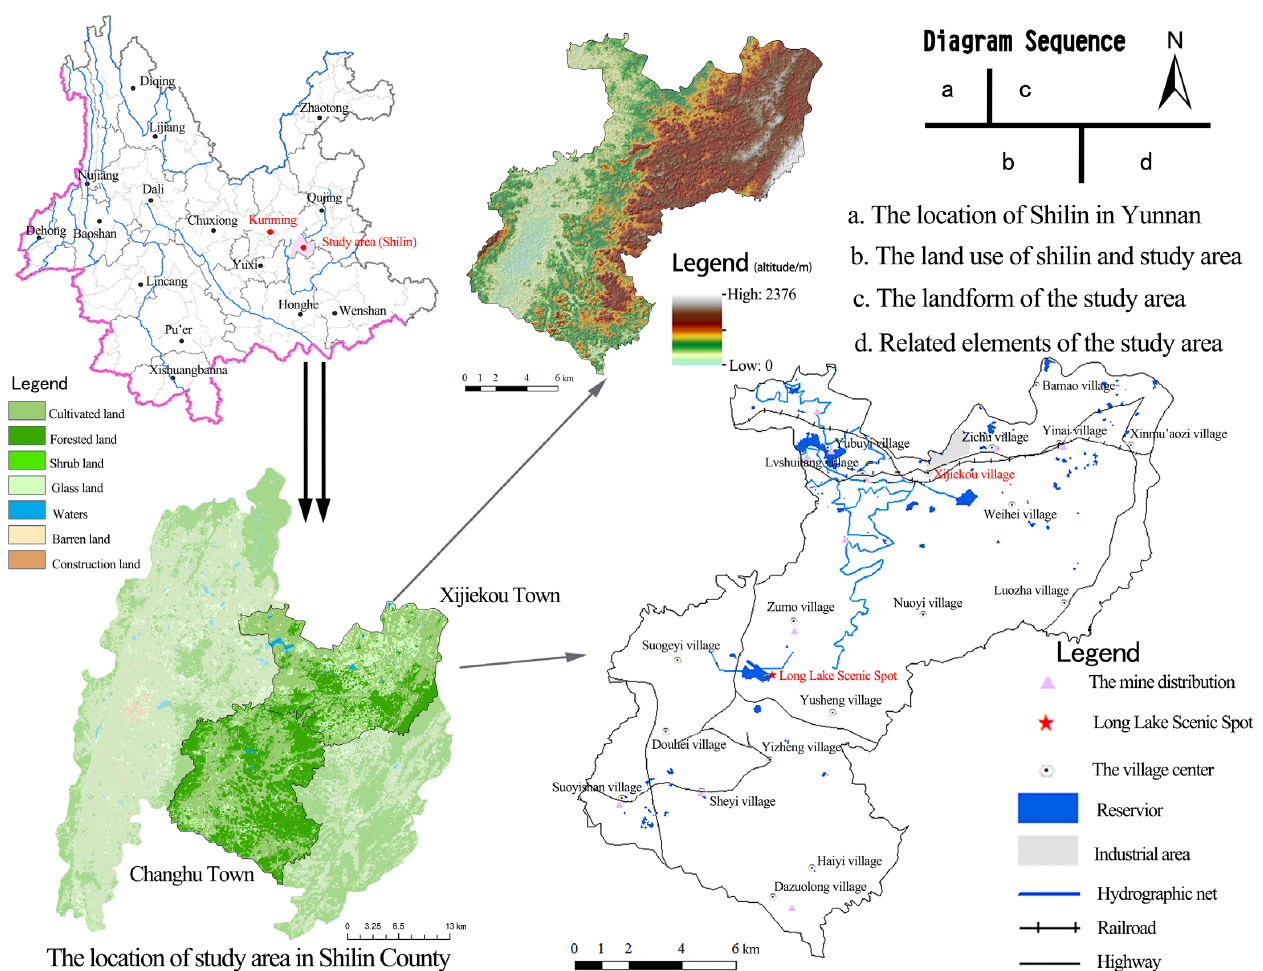
Figure 1. Overview of the study area.